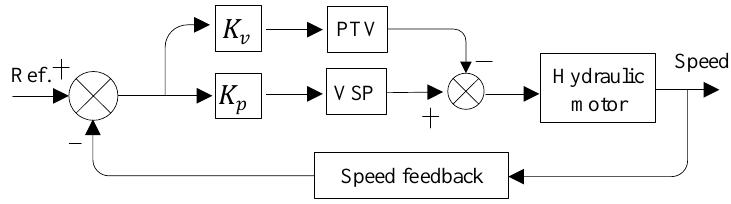
Figure 2 ． Control principle of leaking valve-pump parallel control. Figure 2. Control principle of leaking valve-pump parallel